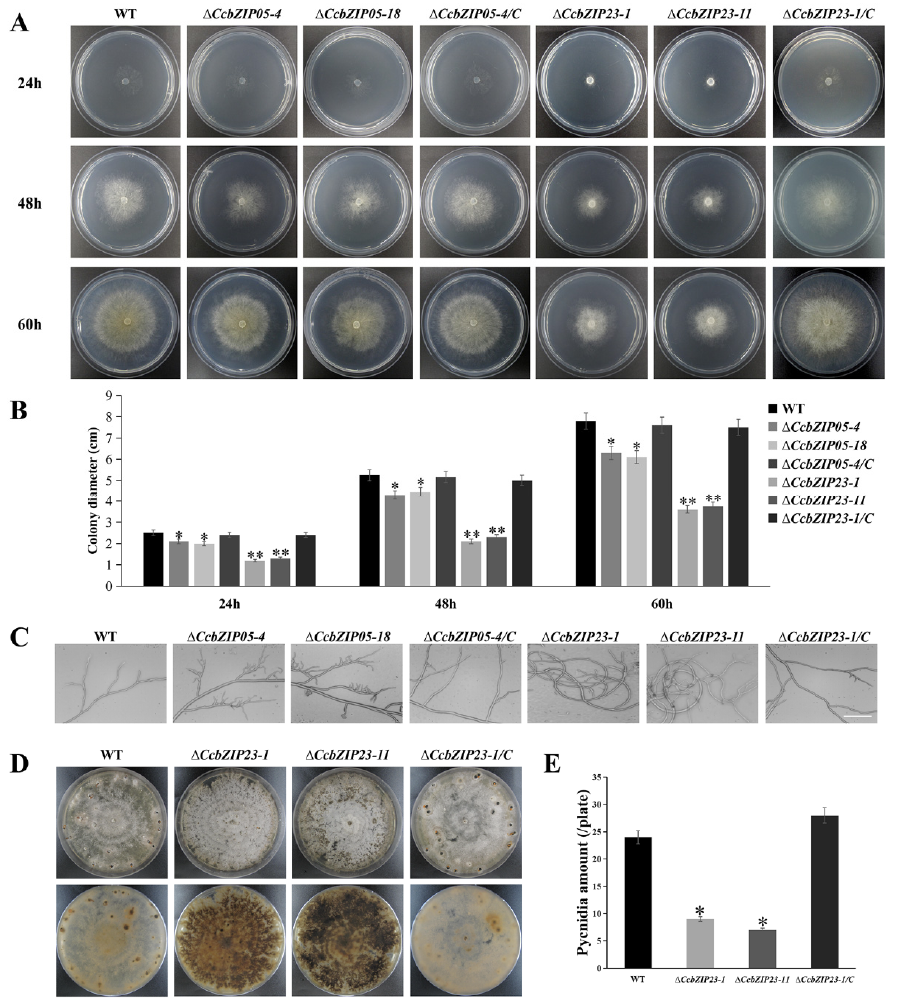
Figure 6. Phenotypic analyses of Δ CcbZIP05 and Δ CcbZIP23 mutants. ( A ) Colony morphologies of the wild-type, gene deletion mutants, and complemented strains after 24, 48, and 60 h grown on PDA plates. ( B ) Colony diameters of the strains on PDA plates shown in the part ( A ). ( C ) Hyphal branches in the tested strains cultured on PDA plates at 25 °C (scale bar = 50 μ m). ( D ) Colony morphologies and pycnidia formation of the wild-type, gene deletion mutants, and complemented strains after 30 days growth on PDA plates. ( E ) Quantification of pycnidia production in each strain. The error bars represent the standard deviations based on three independent biological replicates. The asterisks indicate significant differences (* p < 0.05, ** p <